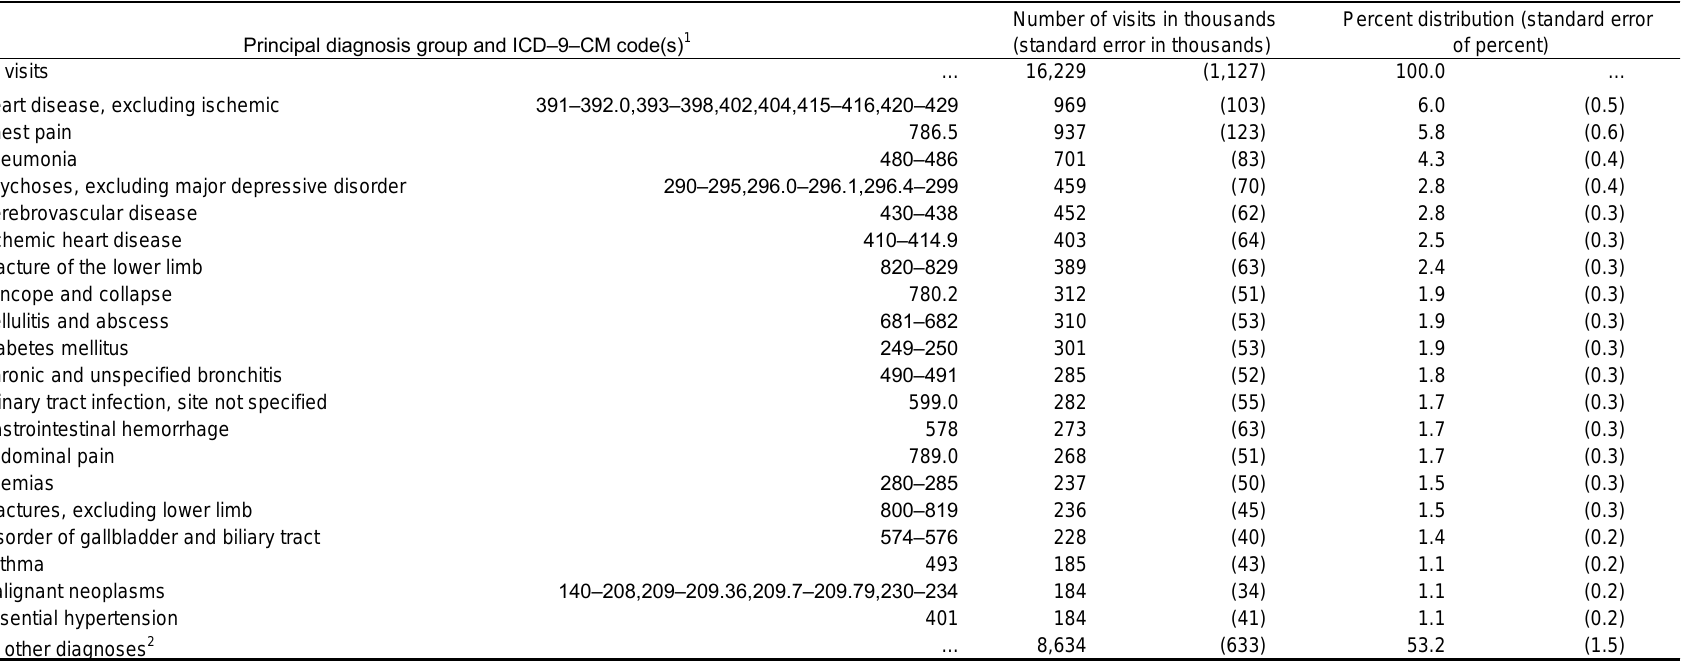
Table 26. Twenty leading principal hospital discharge diagnosis groups for emergency department visits: United States, 2011 Principal diagnosis group and ICD–9–CM code(s) 1